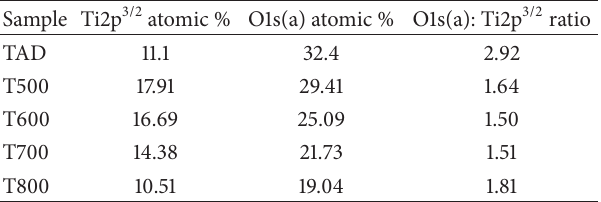
Table 2: Atomic percentages of Ti2p and O1s obtained from XPS spectra along with the atomic ratio of oxygen to titanium in the TiO 2−𝑥